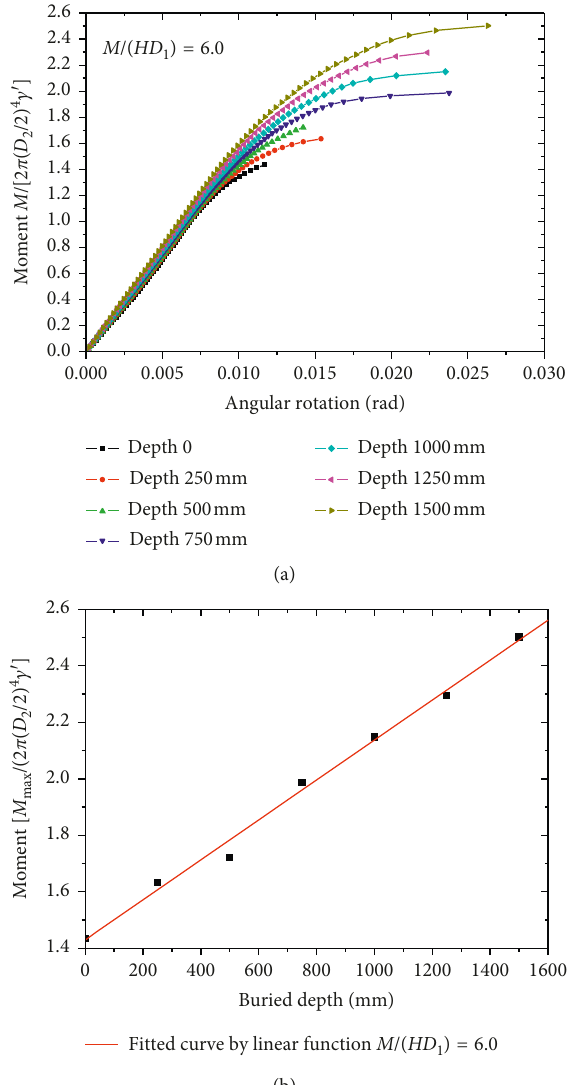
Figure 18: Moment versus rotation angle under various buried depths. (a) Moment versus rotation angle. (b) Maximum moment versus buried